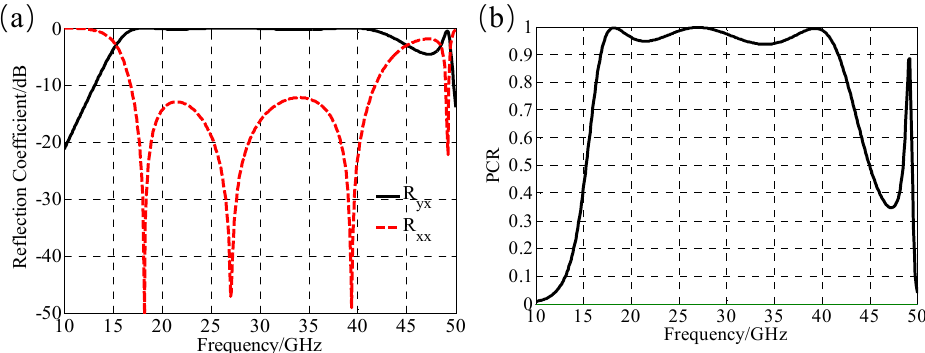
Figure 2. The simulated results. ( a ) The reflection coefficients in the range of 10 GHz–50 GHz; ( b ) the polarization conversion ratio.